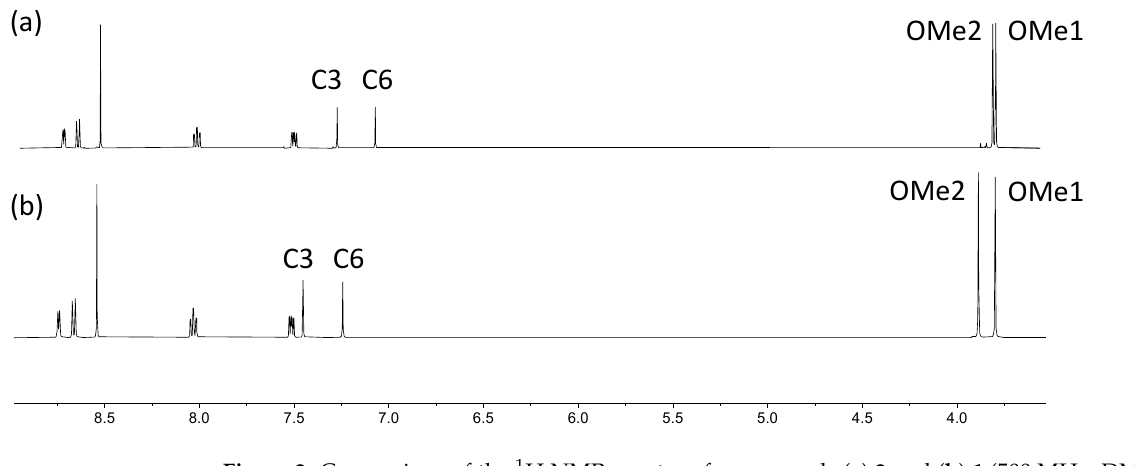
Figure 2. Comparison of the 1 H NMR spectra of compounds ( a ) 2 and ( b ) 1 (500 MHz, DMSO-d 6 , 298 K). The resonance for the CH 3 protons in 2 at δ 1.32 ppm is not shown (see Figure S11 for the full spectrum).